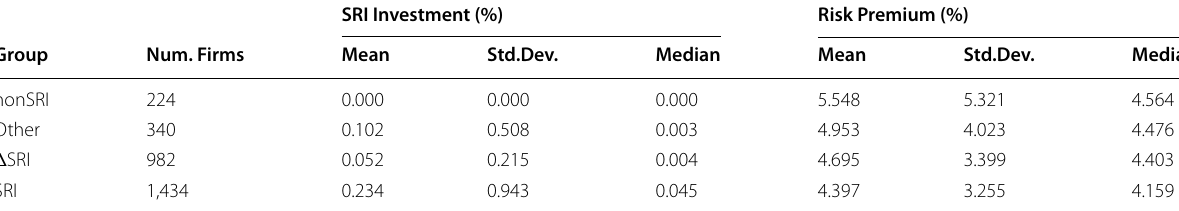
Table 1 Summary statistics of SRI investment and cost of equity capital SRI Investment